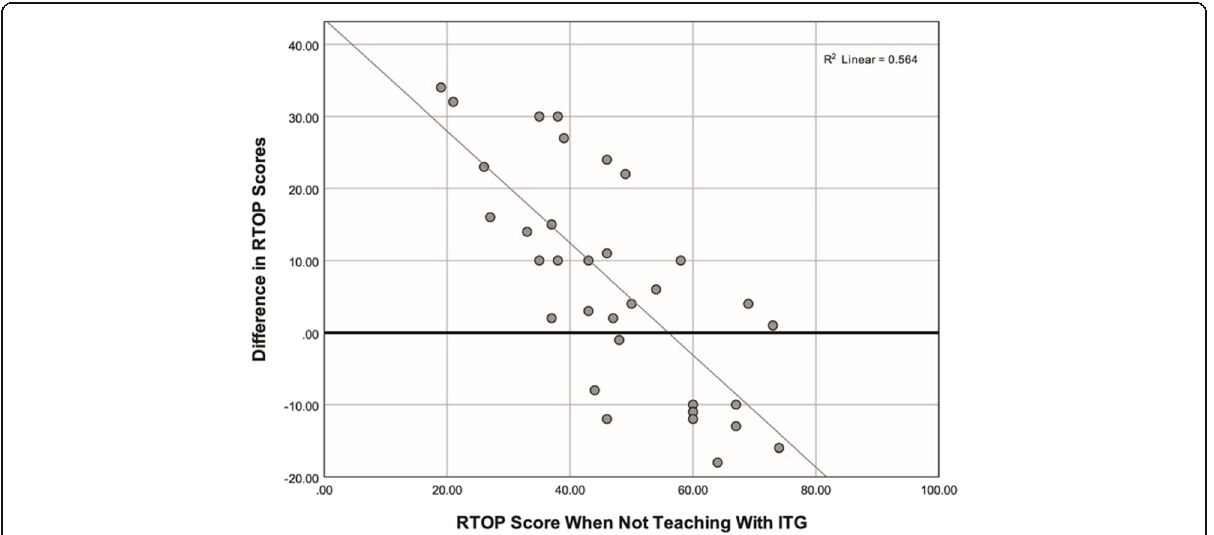
Fig. 6 Difference in RTOP score for paired observations when teaching with and without ITG plotted against RTOP score when not teaching with ITG (positive difference indicates the ITG score is greater than the non-ITG